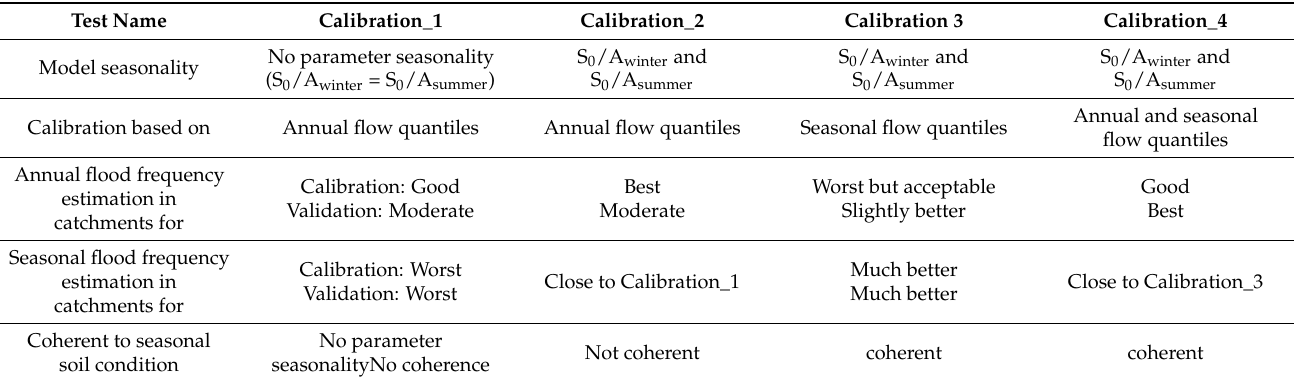
Table 2. Calibration test names and